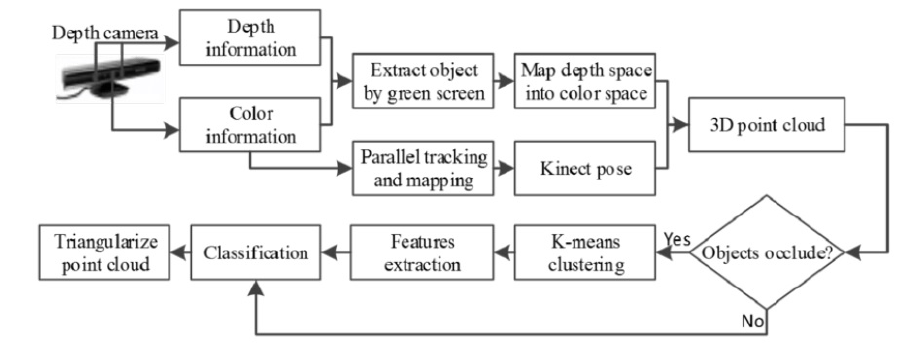
Fig. 5 3D data acquisition